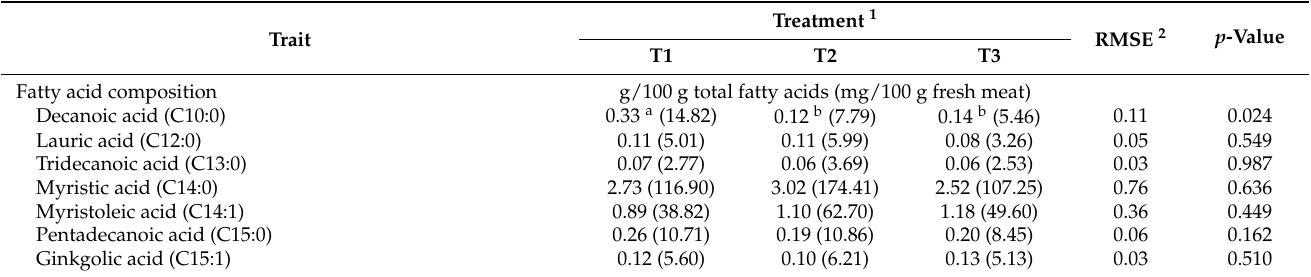
Table 4. Effect of dietary-energy-density treatment (T) 1 on fatty acid composition of Longissimus thoracis muscle of native Thai cattle aged for 2